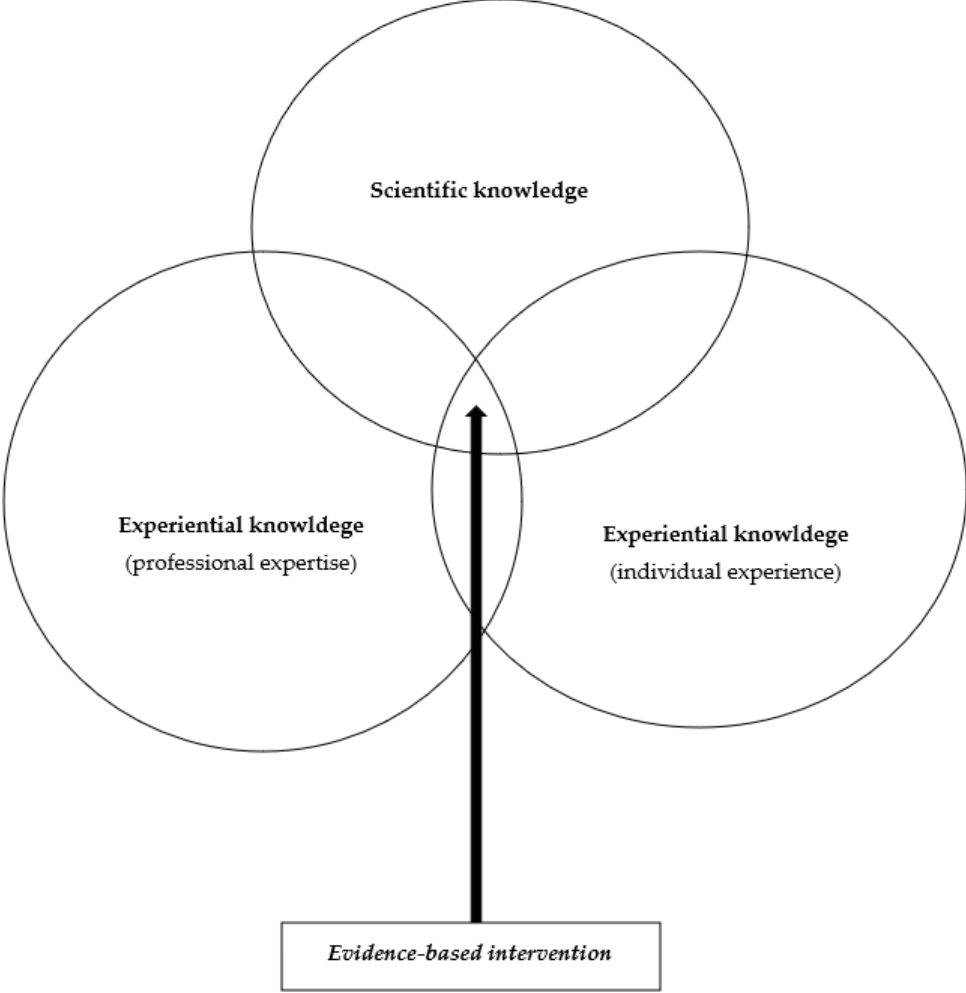
Figure 2. Schematic representation of an intervention according to the evidence-based medicine (EBM) paradigm applicable to evidence-based mental health prevention and promotion.